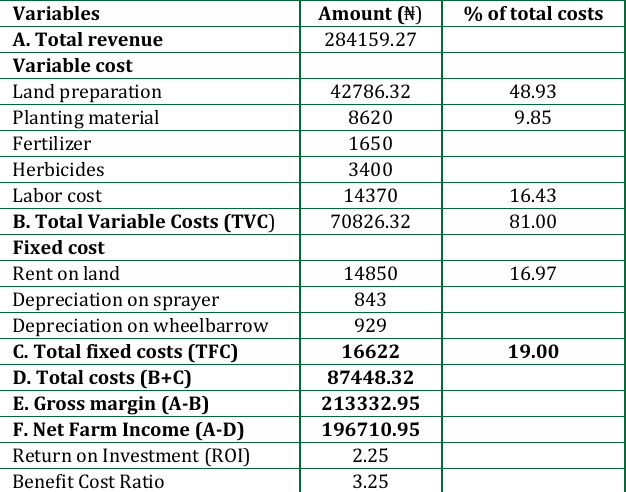
Table 8: Average costs andff return to bio-fortified cassava production per season